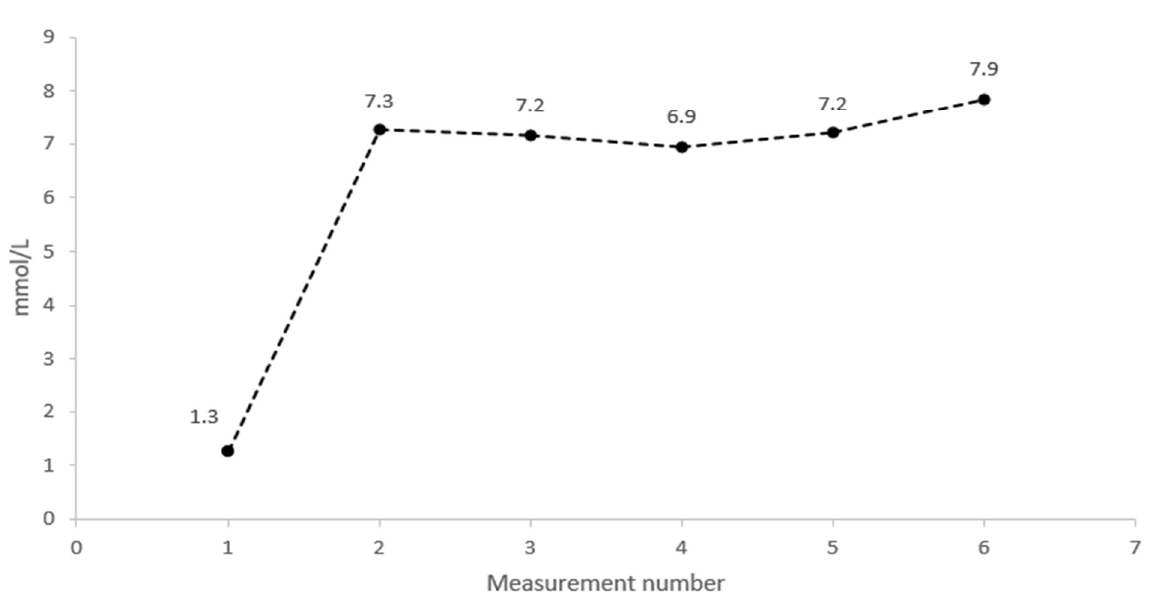
Figure 2. Time plot of the lactate measurement levels during the protocol, at baseline (rest) and the following each completed round.